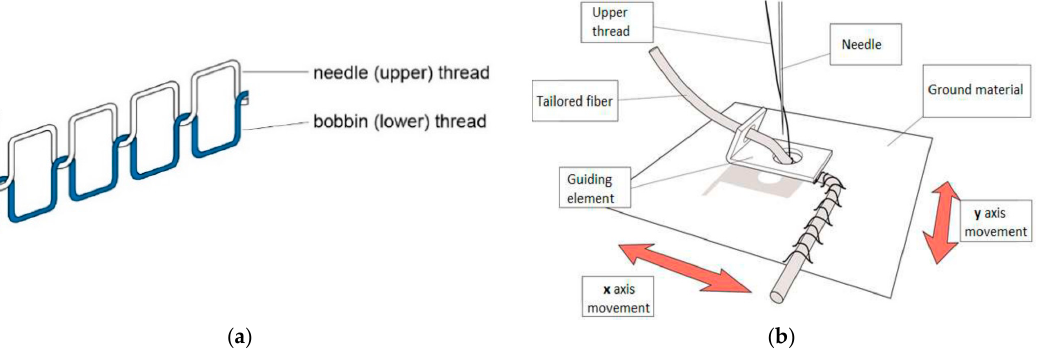
Figure 3. ( a ) Double lockstitch embroidery. The upper thread can be conductive; ( b ) Tailored fiber placement (TFP) embroidery; useful for fixating of functional fibers [34] .